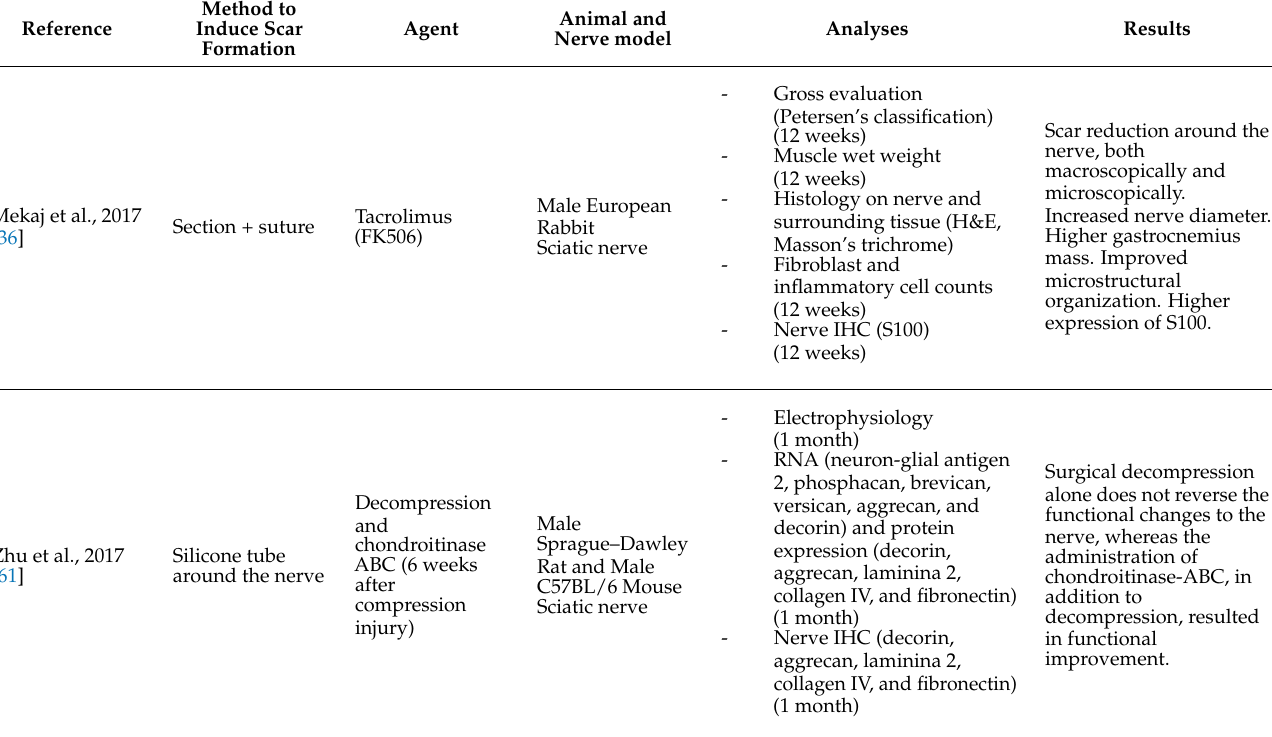
Table 5. Drugs used as antiscarring